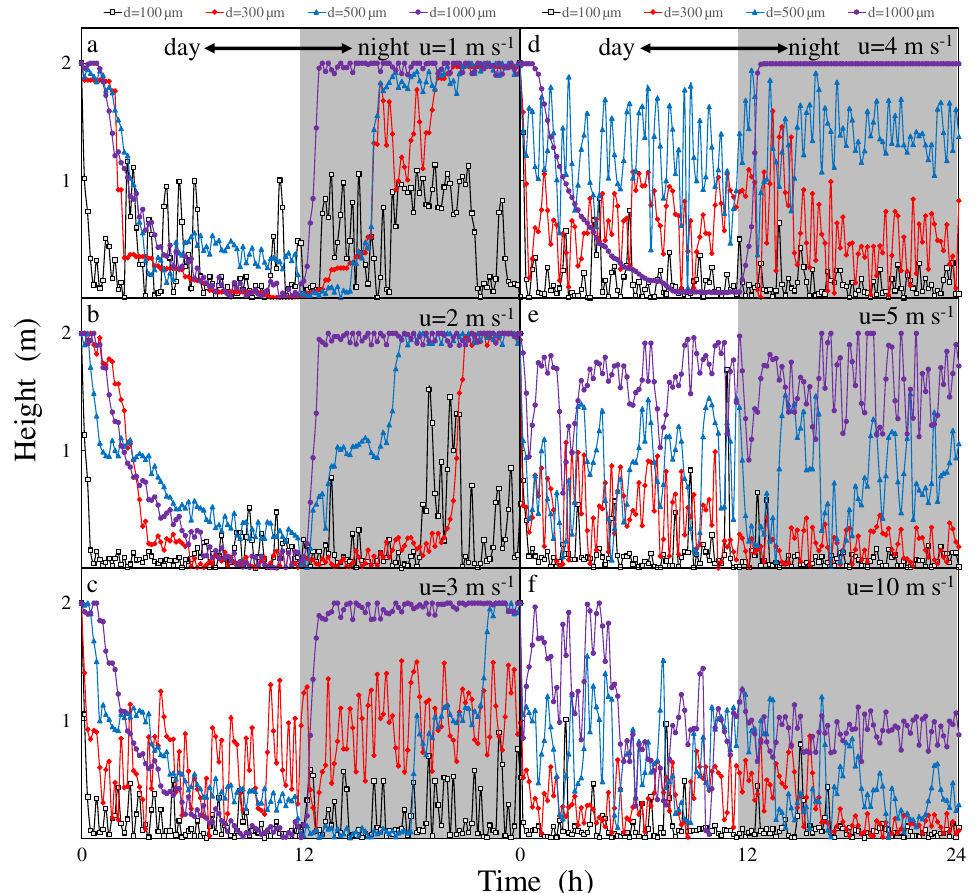
Figure 6. Vertical migration of Microcystis colonies under the effect of wind and light: ( a ) 1 m s −1 , ( b ) 2 m s −1 ,